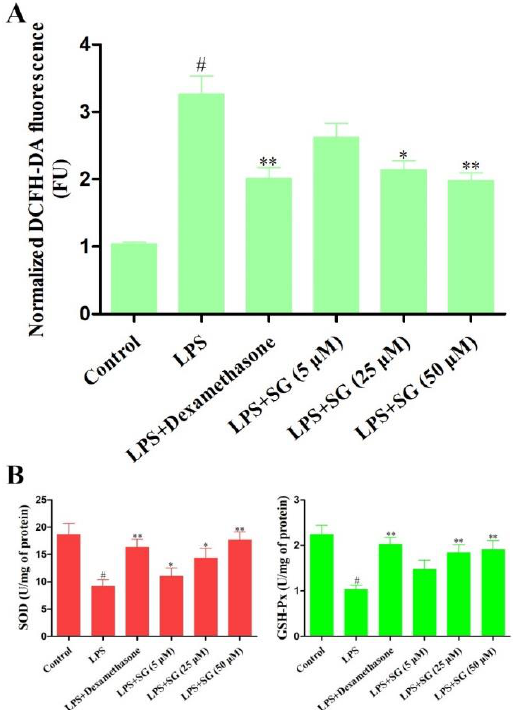
Figure 4. Effect of SG on LPS-stimulated oxidative stress. ( A ) Effect of SG on LPS-triggered ROS production in mMECs. ( B ) The activities of anti-oxidative enzymes were determined using commercial kits. Data are presented as the means ± SEMs of three independent experiments. The symbol # indicates p < 0.05 vs. the control group. The symbols * and ** represent significant differences at p < 0.05 and p < 0.01,